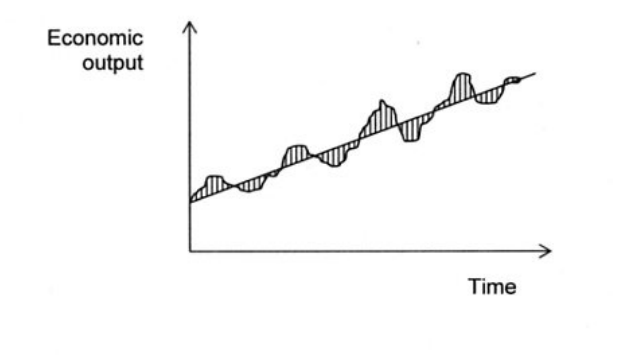
Fig. 1 . Long-term economic growth with short-term downturns (adapted from Boulding 1955:451, Fig. 65B).